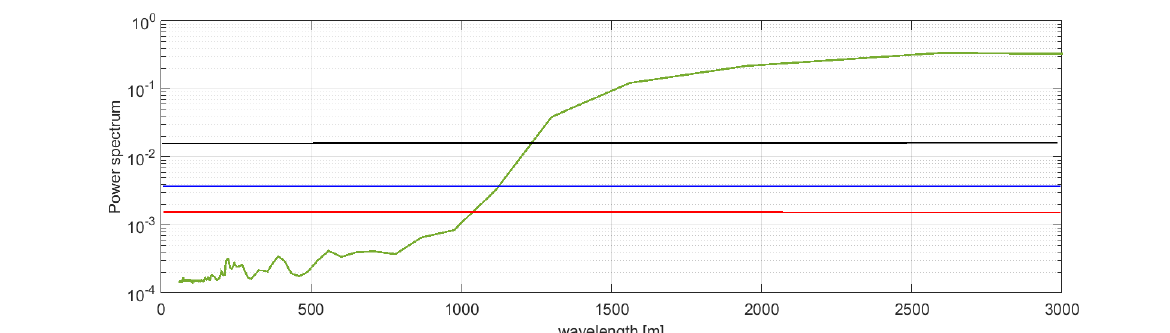
Figure 7. Signal power spectrum (green line), compared with the theoretical power spectrum of a white noise with standard deviation equal to 0.67 mGal (red line), 1 mGal (blue line), and 1.4 mGal (black